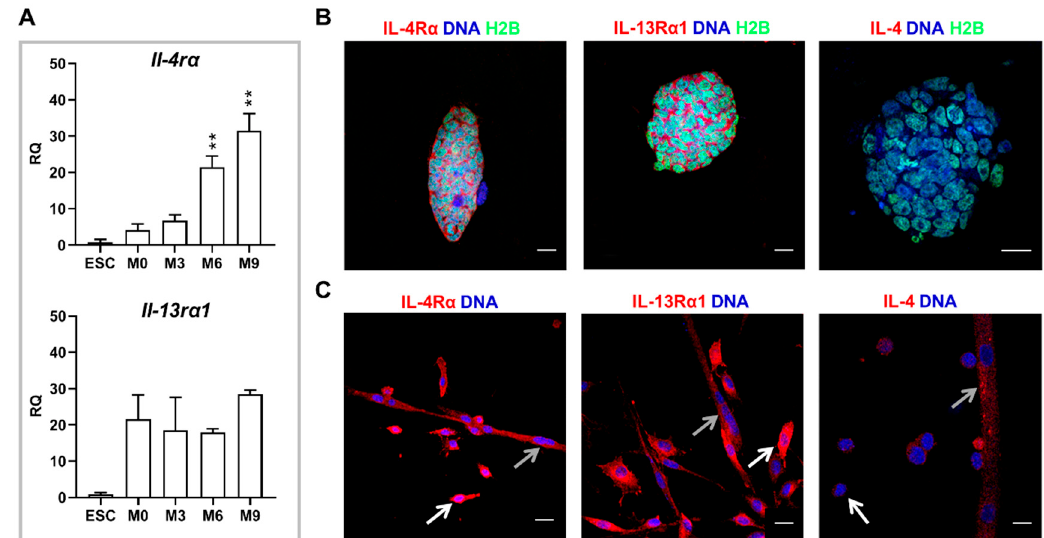
Figure 1. Analysis of expression of IL-4 and IL-4 type II receptor subunits in undifferentiated mouse ESCs and mouse primary myoblasts. ( A ) Expression of Il-4r α and Il-13r α 1 in undifferentiated ESCs and primary myoblasts analyzed at four stages of the culture: M0 (freshly isolated satellite cells), M3 (day 3 of the culture, predominately proliferating myoblasts), M6 (day 6 of the culture, predominately fusing myoblasts), and M9 (day 9 of the culture, predominately myotubes). β -actin was used as a reference gene. RQ = 1 for the level of gene expression detected in 13.5-day-old mouse embryo. Data are presented as the means of three independent experiments with standard deviations; ** p < 0.01. ( B ) Representative images of immunocytochemistry analysis of IL-4R α , IL-13R α 1, and IL-4 in undifferentiated ESCs. Scale bar: 20 μ m. ( C ) Representative images of immunocytochemistry analysis of IL-4R α , IL-13R α 1, and IL-4 in mouse primary myoblasts at day 6 (white arrows indicate myoblasts, grey arrows indicate myotubes). Scale bar: 20 μ m.